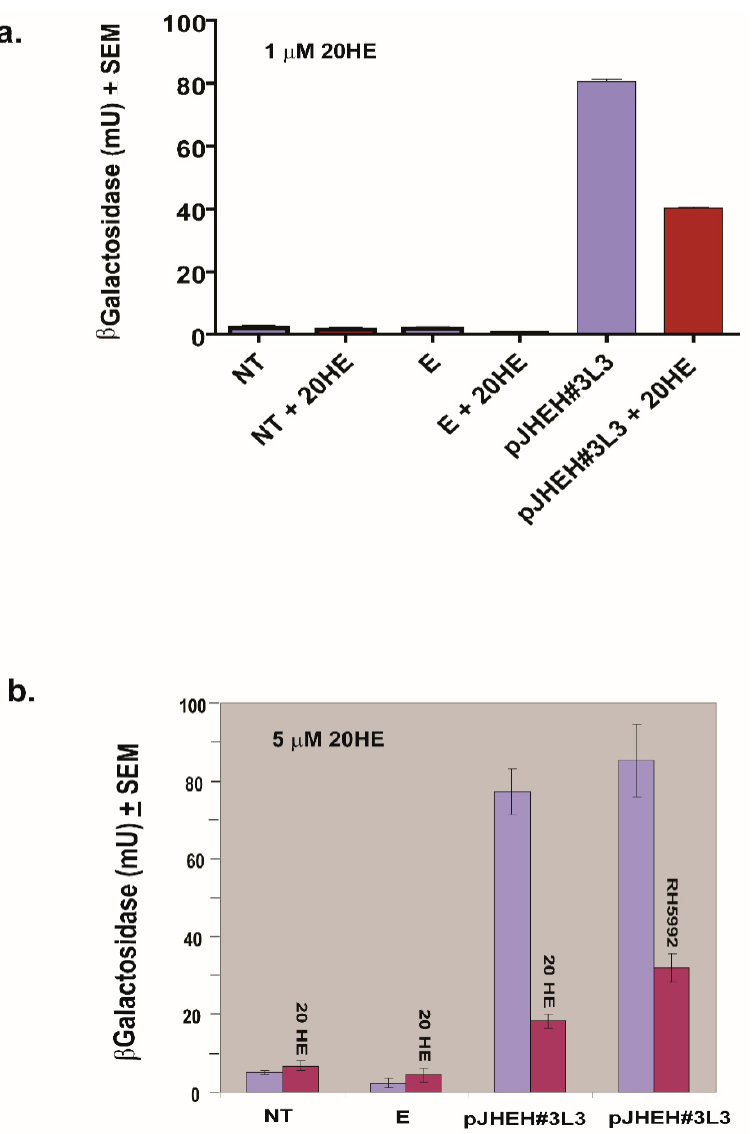
Figure 11. Effects of 20HE and its mimic (RH5992), 5 µ M each, on the transcriptional activity of D.Mel2 transfected with jheh 3 promoter pJHEH#3L3. ( a ) Red colored bars show incubations with 20HE (1 μ M), magenta-colored bars show incubations without 20HE. ( b ). Red-colored bars show incubations with 20HE or RH5992 (5 μ M), magenta-colored bars show incubations without 20HE. NT—Non-transfected cells, E—cells transfected with an empty plasmid. See Figure 7 for promoter pJHEH#3L3 sequence length.